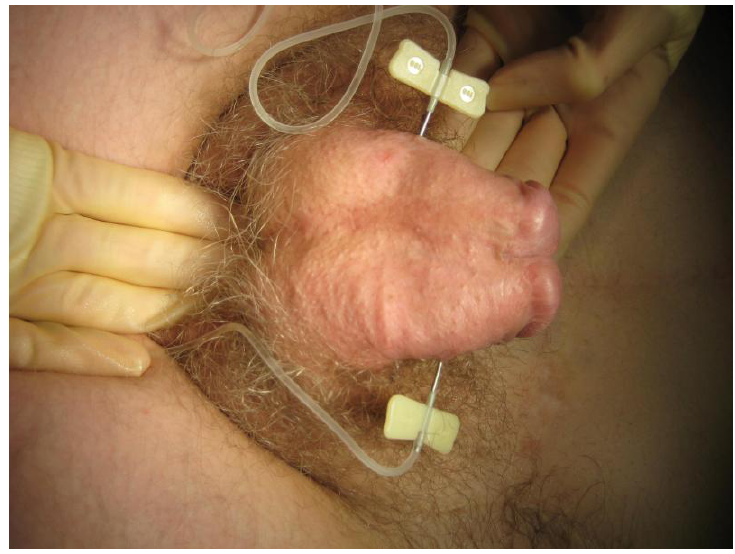
FIGURE 1 Artificial erection being performed in a patient with bladder